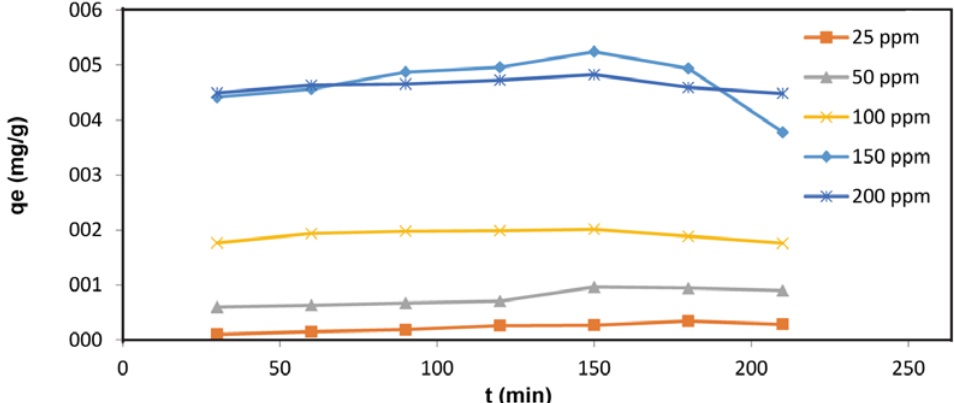
Figure 3 . The sorption equilibration time of 2,4-DCP by dried sweetgum bark (biomass: 1 g, 2,4-DCP concentration: 25, 50, 100, 150, 200 mg/I: temperature 20 ± 0.5, agitation rate: 125